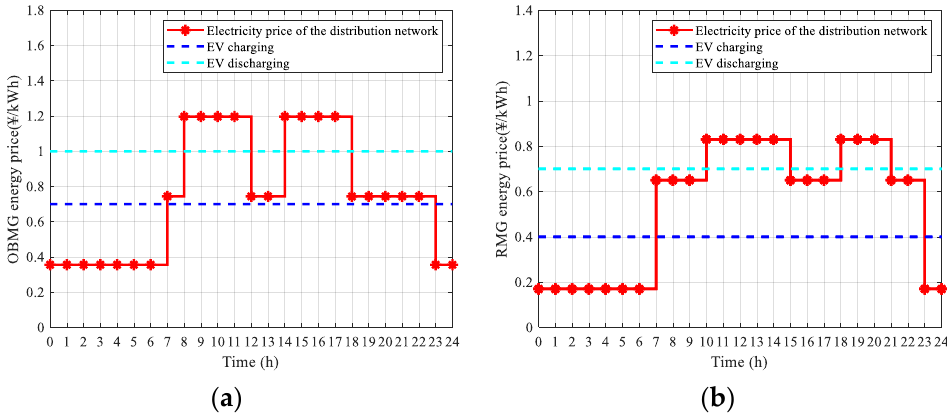
Figure 7. ( a ) Prices of energy exchanging in OBMG; ( b ) prices of energy exchanging in